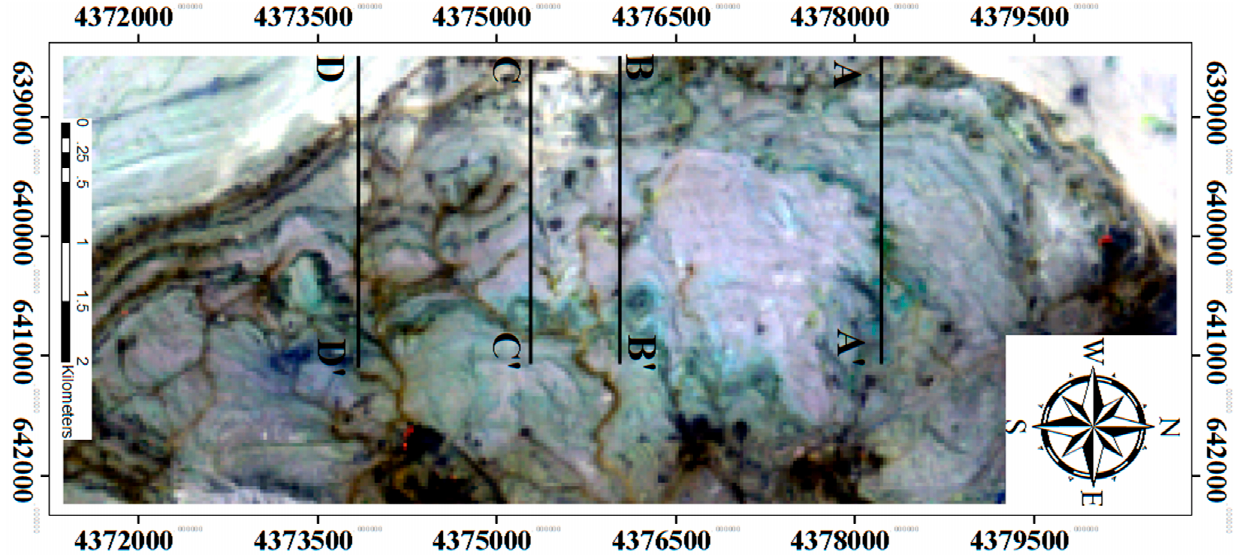
Figure 5. Location of the sampling spatial profiles shown on the 3 May 2003 Landsat TM standard false composite image of